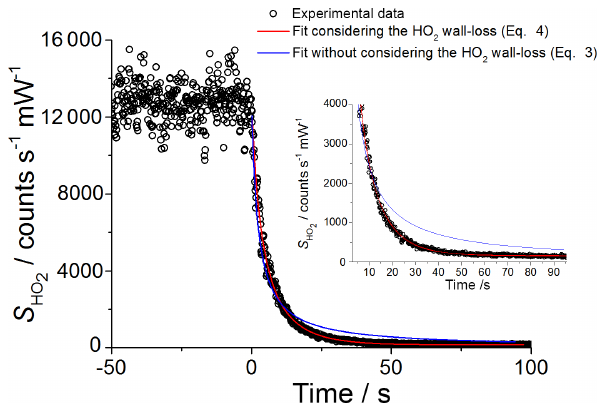
Figure 1. An example of temporal decay of the nor- malised FAGE HO 2 signal with 0.1s time resolution recorded at 295K and 150mbar mixture of N 2 : O 2 = 4 : 1 using Cl 2 / CH 3 OH and the black lamps (details given in the main text): [Cl 2 ] 0 ∼ 3 × 10 13 moleculecm − 3 and [CH 3 OH] 0 ∼ 5 × 10 13 moleculecm − 3 . At time zero the photolysis lamps were turned off. Fit- ting Eq. (4) to this example trace (red line) gave = (2.45 ± 0.06) × 10 − 7 countscm 3 molecule − 1 s − 1 mW − 1 C HO 2 ( r 2 = 0.99), while fitting Eq. (3) to the data (blue line) = (1.06 ± 0.02) × 10 − 7 countscm 3 molecule − 1 led to C HO 2 s − 1 mW − 1 ( r 2 = 0.95) – statistical errors at 1 σ level. The inset shows the fit to the data using the two equations at later times. Note that the most significant source of the signal noise is the shot noise (Poisson noise), which grows with the number of photons counted by the detector.